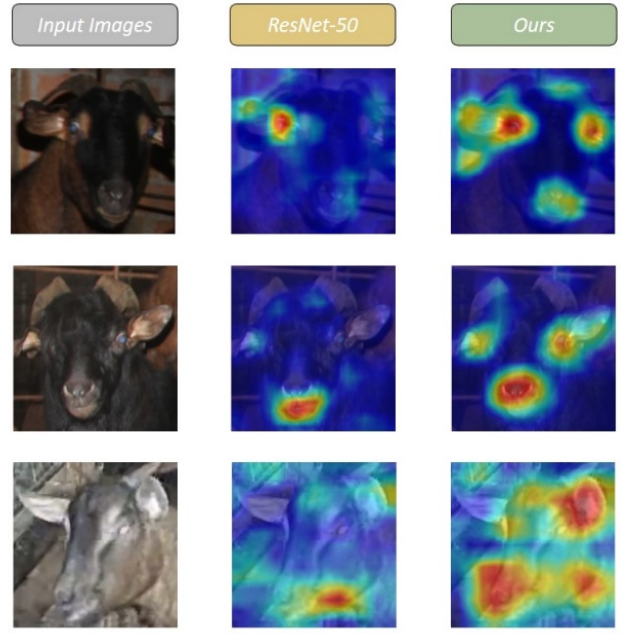
Figure 11. Feature map visualization based on the last convolutional layer of the backbone. The first column shows the original images, while the second and the third columns show the maximally responding feature maps from the ResNet50 and our classifier, respectively.